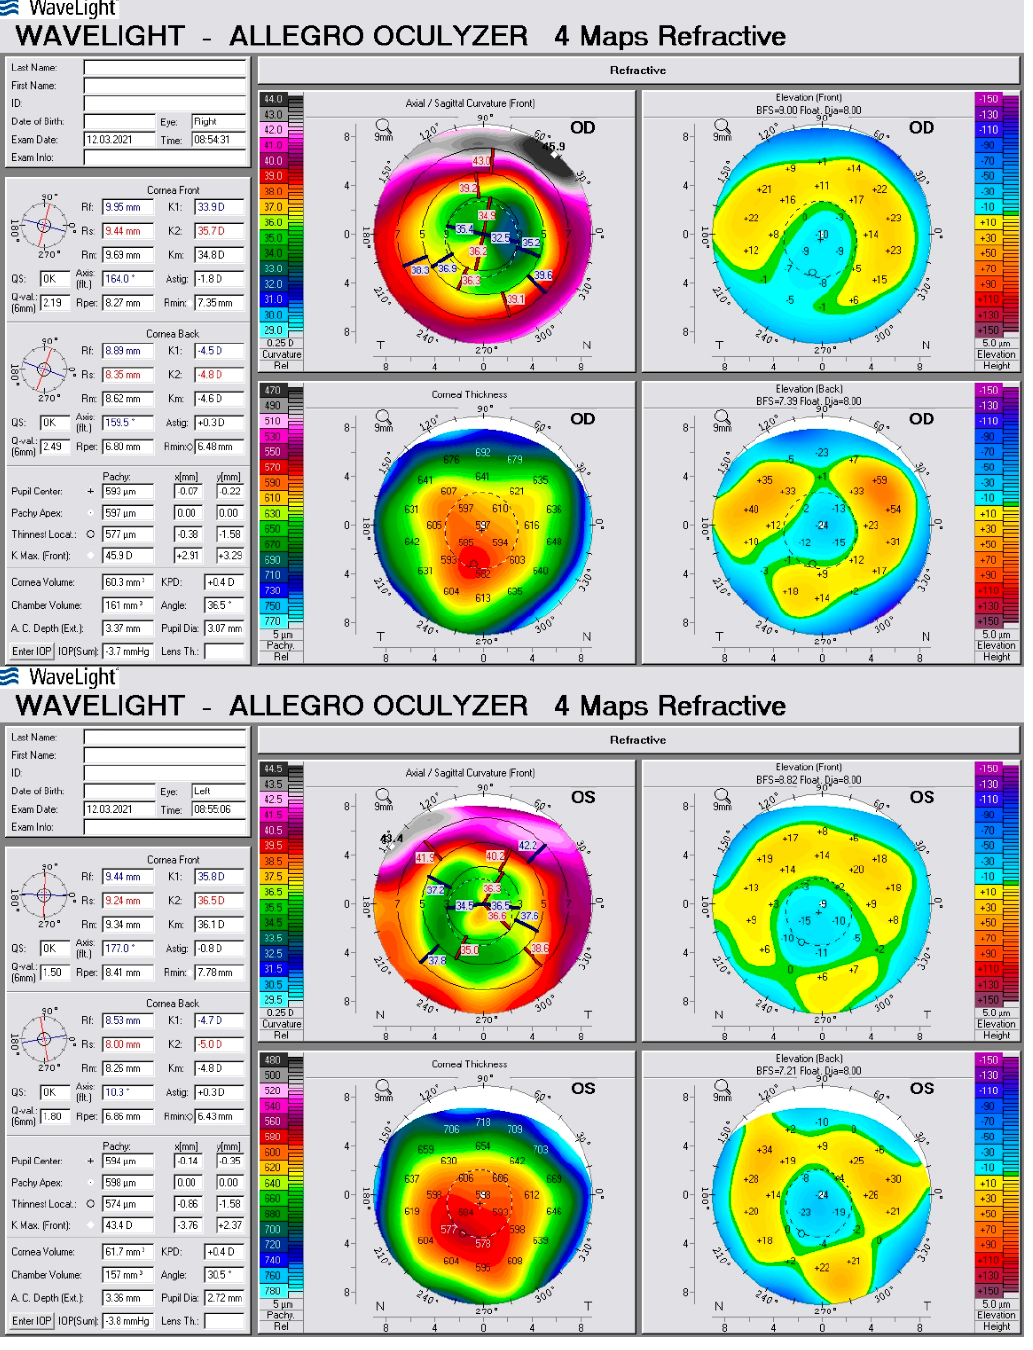
Figure 3. Corneal tomography shows irregular astigmatism in both eyes. Only the OS corneal curvature was measured using the Argos optical biometer. We were unsuccessful in measuring the curvature in OD. Both eyes were examined without any problems on the IOL Master 500 biometer. To calculate the implant power on the Argos optical biometer, we used results of K1 and K2 from IOL Master (Figure 4). Considering the presence of the irregular and asymmetrical astigmatism of low value, seen in the topography, the implantation of a toric lens was